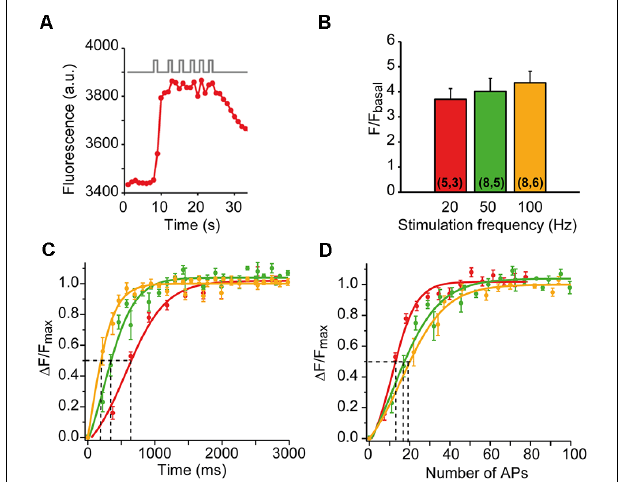
FIGURE 3 | mCa 2+ responses to different patterns of nerve stimulation. (A) mCa 2+ increases to six successive trains of 1-s duration at 50 Hz in a representative nerve terminal. (B) The average increase in fluorescence ( ∆ F/F basal ) at 20, 50, and 100 Hz. The numbers of terminals and mice recorded are in parentheses. (C,D) Average fluorescence increase ( ∆ F/F max ) as a function of time (C) and number of AP (D) at 20 (red symbols), 50 (green symbols), and 100 (yellow symbols) Hz. The solid lines are sigmoidal fit on the data. The time required to reach half-maximum mCa 2+ (dotted lines in C ) varies between 650 ms (20 Hz) and 190 ms (100 Hz). Half-increase in fluorescence is achieved with 13–19 AP (dotted lines in D ). The apparent higher sensitivity of the response at 20 Hz in (D) is probably not such but reflects the time-dependent component of the response, as shown in (C) .